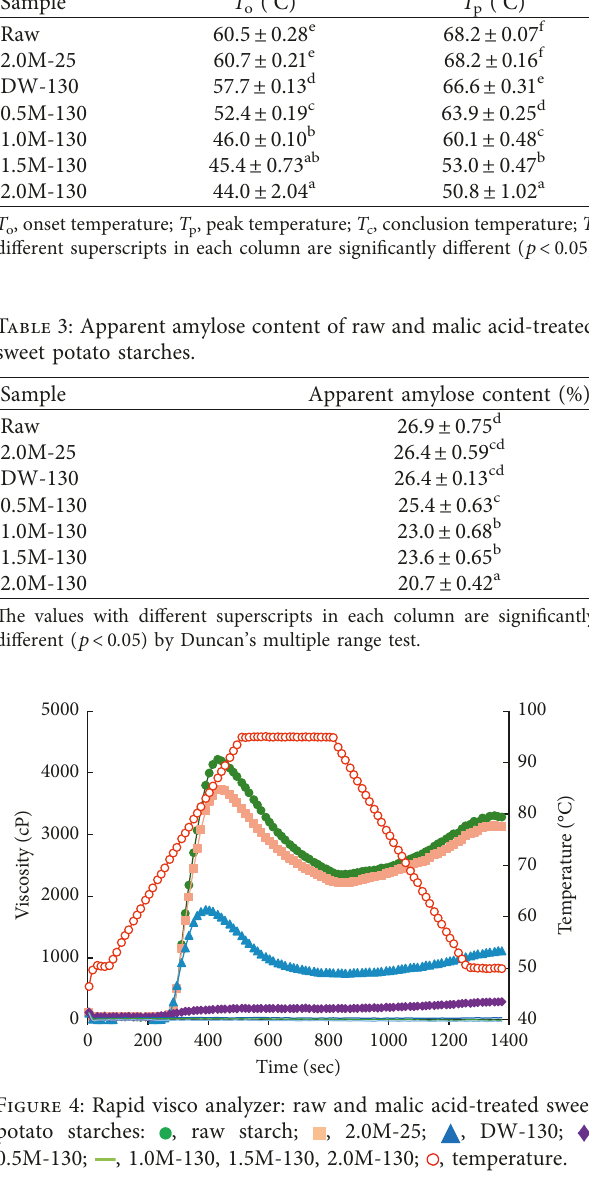
Table 2: Gelatinization parameters of raw, control, and malic acid-treated starches. Sample